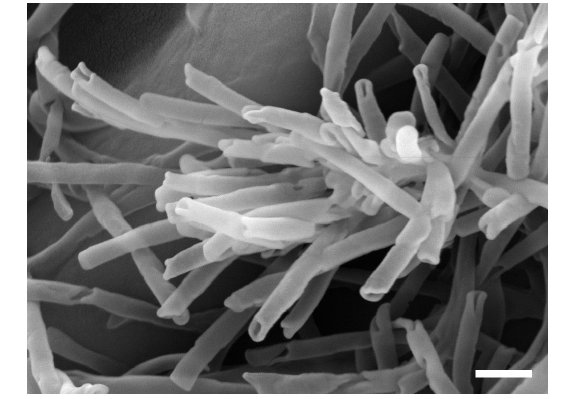
Figure 1: SEM micrograph of ß-diketone tubules on an E. gunnii leaf surface. Scale bar 400